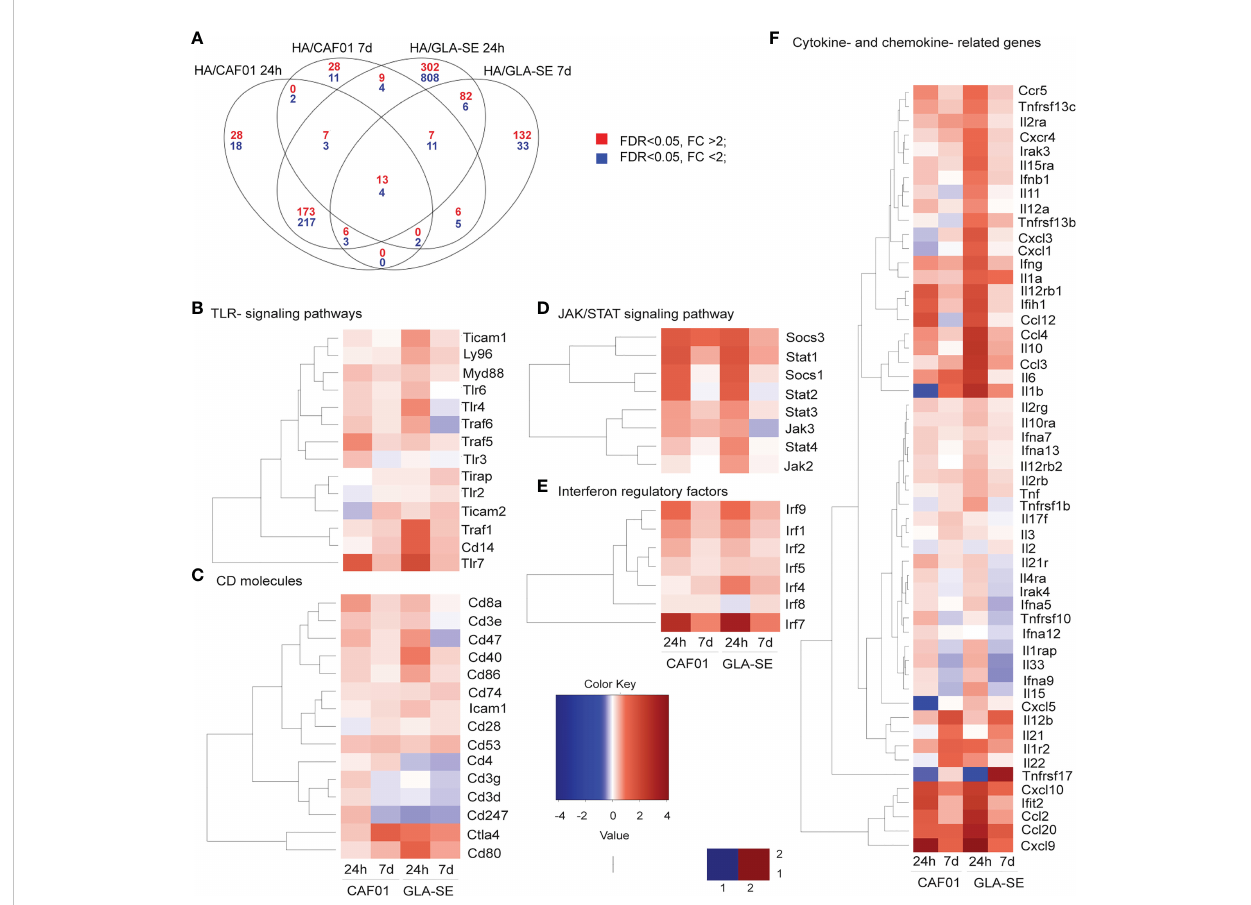
FIGURE 2 Transcriptomic pro fi ling of whole draining LNs from neonatal mice responding to HA/CAF01 or HA/GLA-SE. Groups of neonatal CB6F1 mice were immunized s.c. with HA alone or formulated in combination with CAF01 or GLA-SE. Two draining inguinal LNs were collected 24 h and 7 days post- immunization to perform microarray analysis. (A) The Venn diagram depicts the numbers of unique and shared differentially expressed genes (DEGs) between either adjuvant group compared with the HA alone group, at 24 h and 7 days post immunization as indicated. Blue and red numbers indicate the DEGs that were signi fi cantly downregulated (blue) and upregulated (red), respectively. (B – F) Heat maps show the expression pro fi les of selected genes associated with (B) TLR signaling pathways, (C) genes encoding CD molecules, (D) JAK-STAT signaling pathways, (E) genes encoding interferon regulatory factors, and (F) cytokine- and chemokine-related genes, after CAF01 or GLA-SE at the indicated time